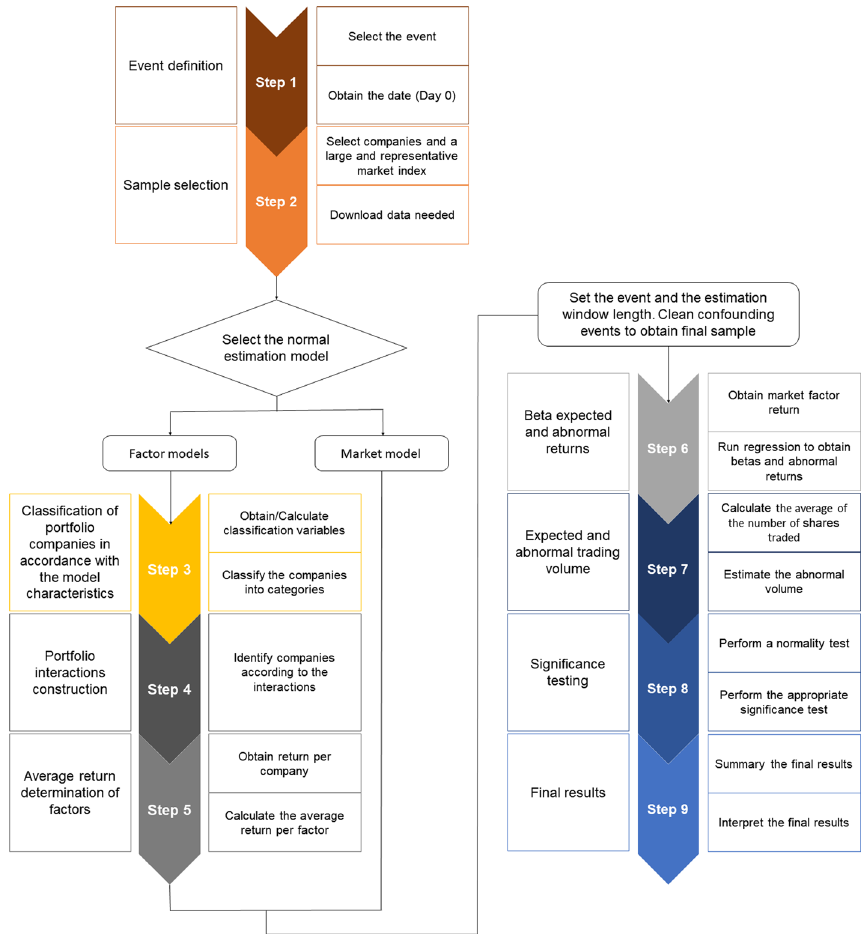
Fig. 1 Flowchart of event study methodology. Source : Created by